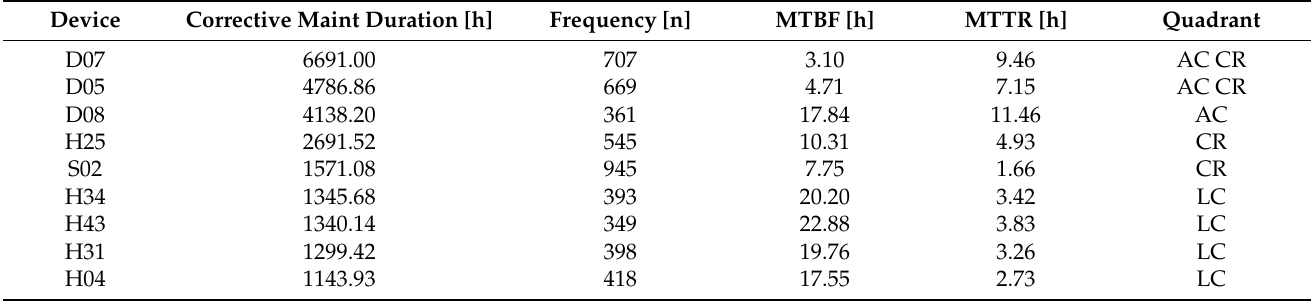
Table 11. Maintainability and reliability data of critical